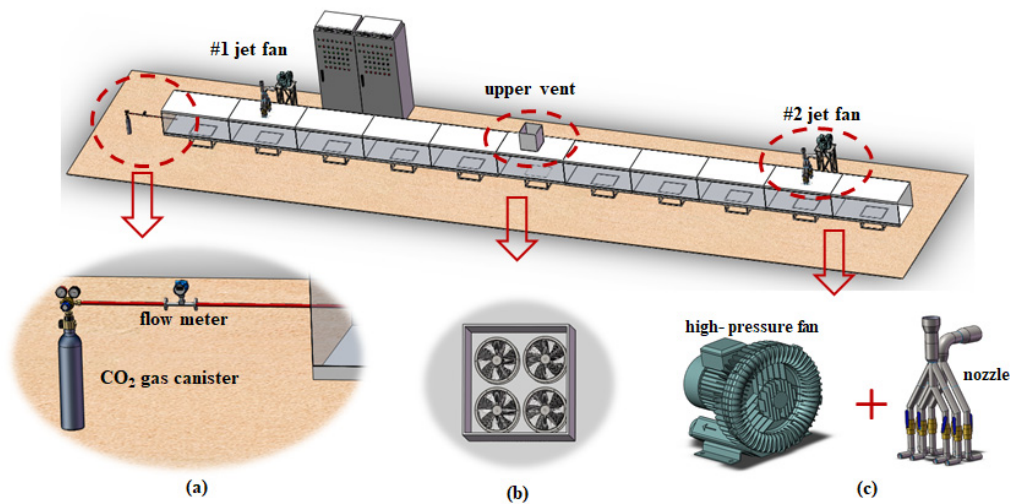
Figure 5. Schematic diagram of the scale model: ( a ) pollutant release device; ( b ) axial fan; ( c ) jet fan simulator.